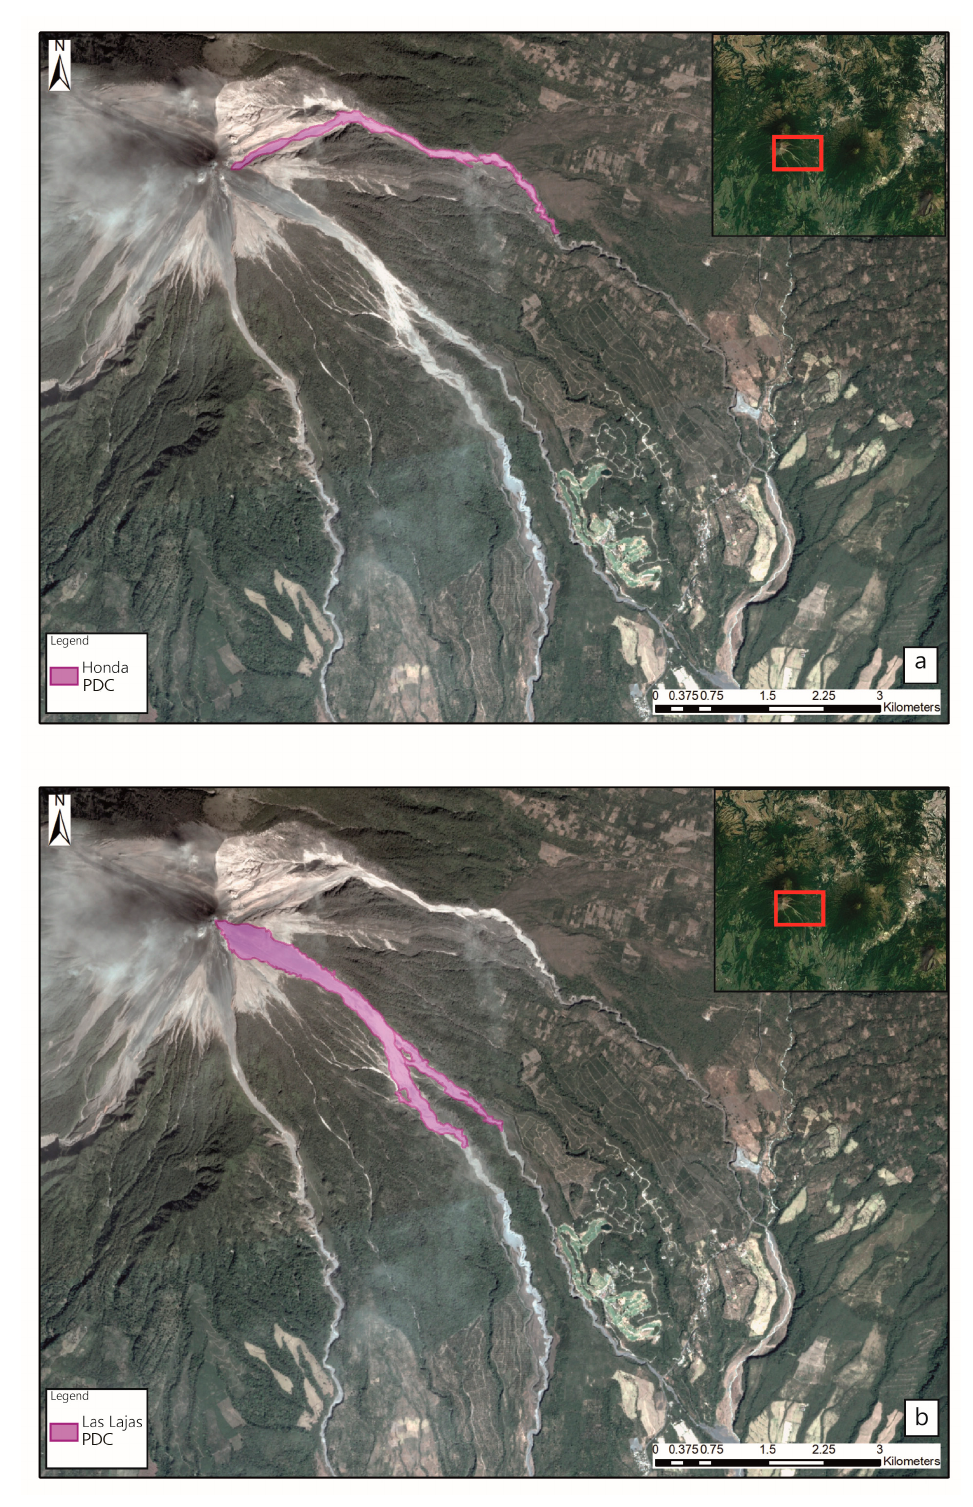
Figure 6. PDC deposits in ( a ) Barranca Honda and ( b ) Barranca Las Lajas and El Jute visually mapped using PlanetScope imagery. The inset shows the location of the displayed area. Background image is from February 2, 2018 at 15:57 UTC.